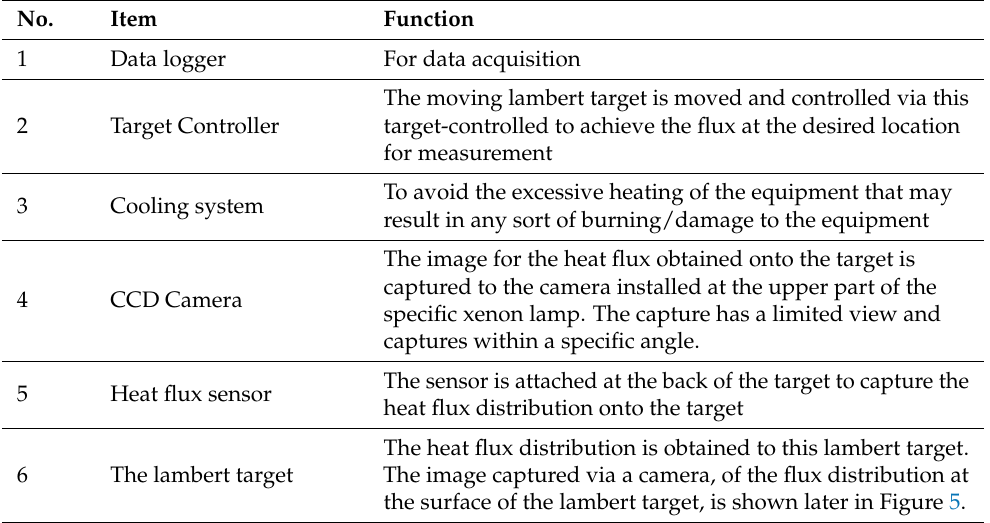
Figure 5. Heat flux obtained on a lambert target produced by lamp 5. Table 3. Components of measurement